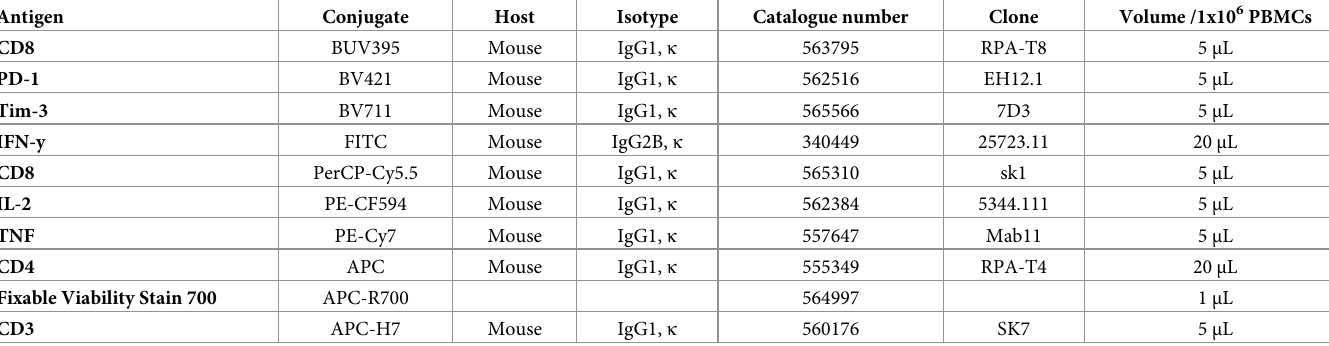
Table 3. Primary antibodies used in intracellular cytokine staining assay. Antigen